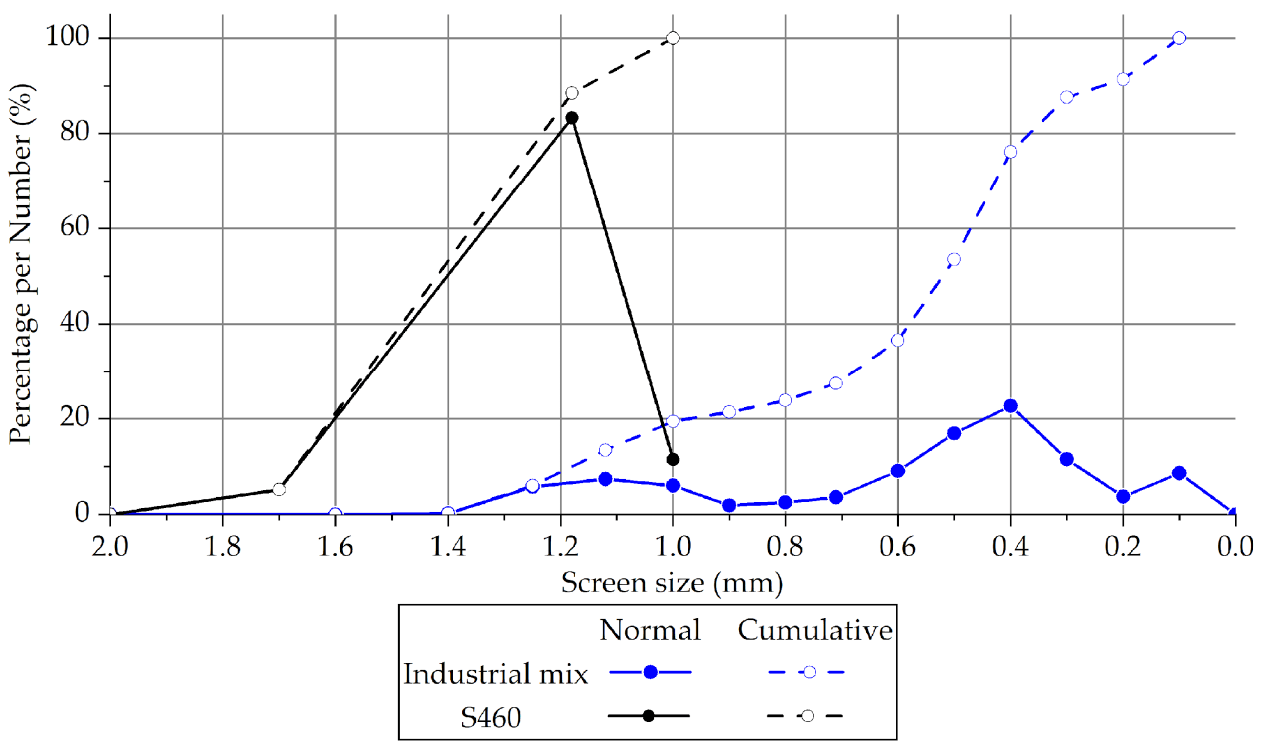
Figure 4. Normal and cumulative operation versus new S460 shot distributions per relative number. The transformation of the relative mass (direct result of the sieve analysis) to the relative shot number considers the average diameter between two consecutive sieves as being the representative one for the respective class. For example, the relative mass of 29% sieved out of the 1.25 mm screen size in the industrial shot mix distribution is transformed into number of shots using the mean diameter of this grid and the previous one of 1.40 mm, resulting in a mean diameter of 1.325 mm. Furthermore, during the abovementioned statistical analysis, it is also vital to calculate the percentage occupied by each shot category (brand new or operational) on the total of the mixture, per relative number and per relative mass. For the current industrial shot mix, this percentage was calculated to ~35% of the total mass for the small (worn)